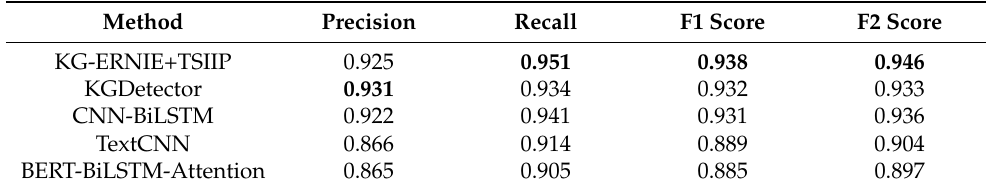
Table 3. Comparisonof experimental results. The bold numbers are the best results.